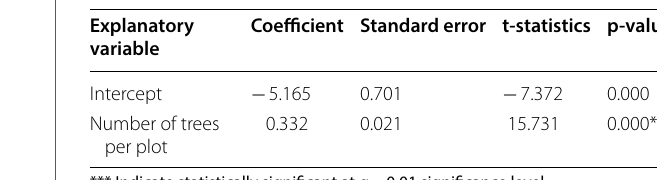
Table 3 Linear regression analysis result of missed trees against total number of